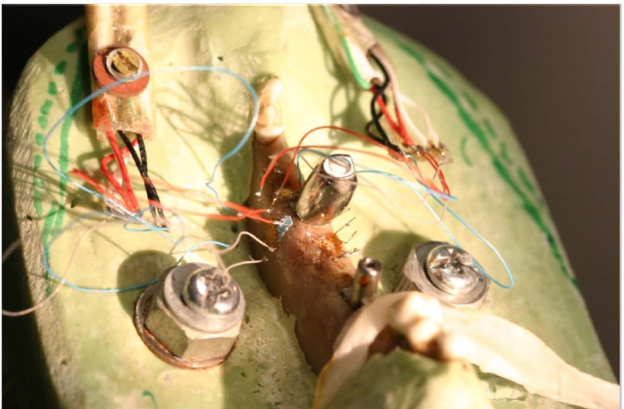
Figure 6. Buccal and mesial wires connected; space limitation meant that only 2 gauges at a time could be used. This image shows the mesial and buccal gauges connected to the